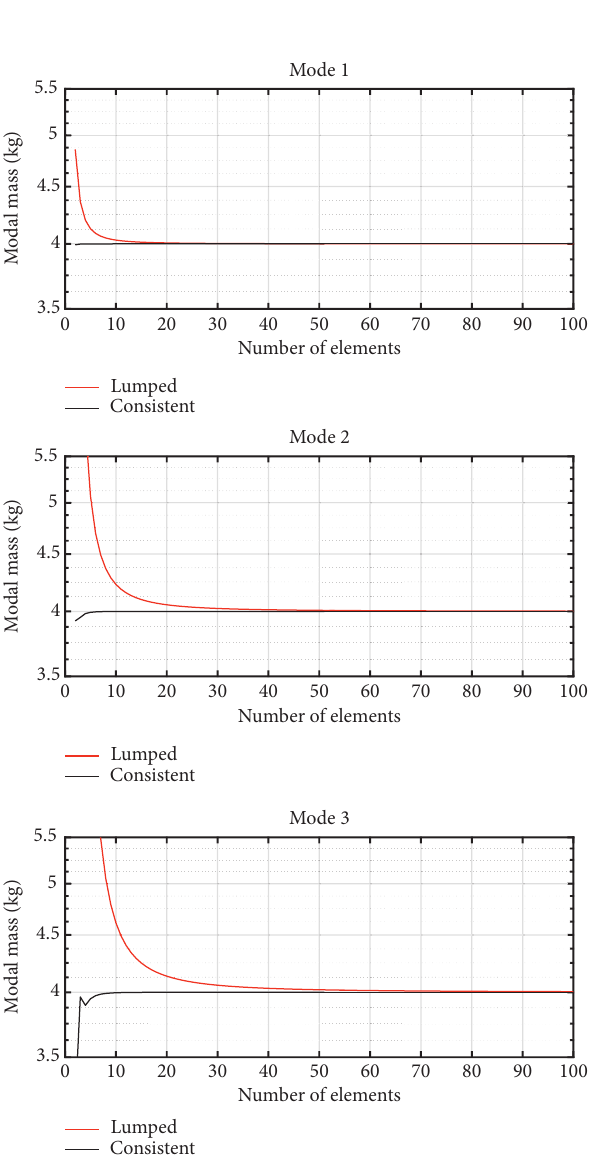
Figure 4: Convergence of the length of the mode shapes for the first three modes of the cantilever beam with constant mass density.